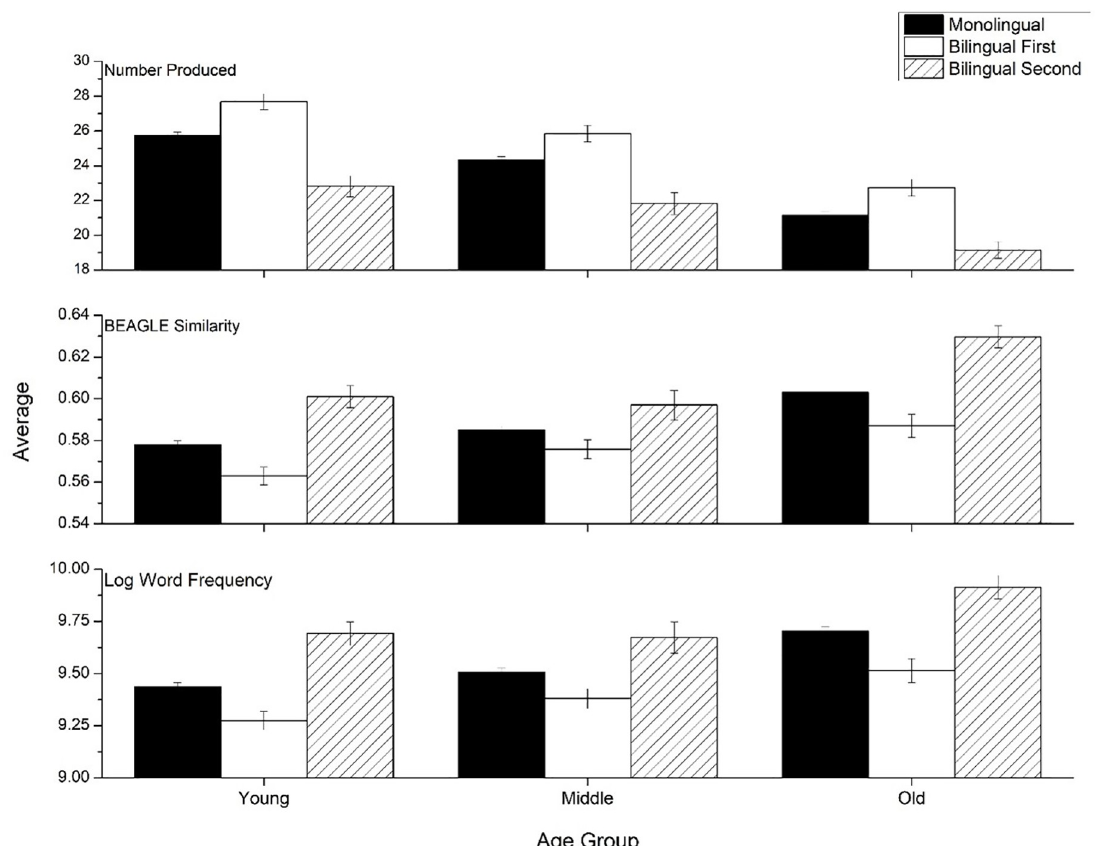
Fig 3. Means for the three psycholinguistic variables across the three language groups by age group. Error bars represent 95% confidence intervals.